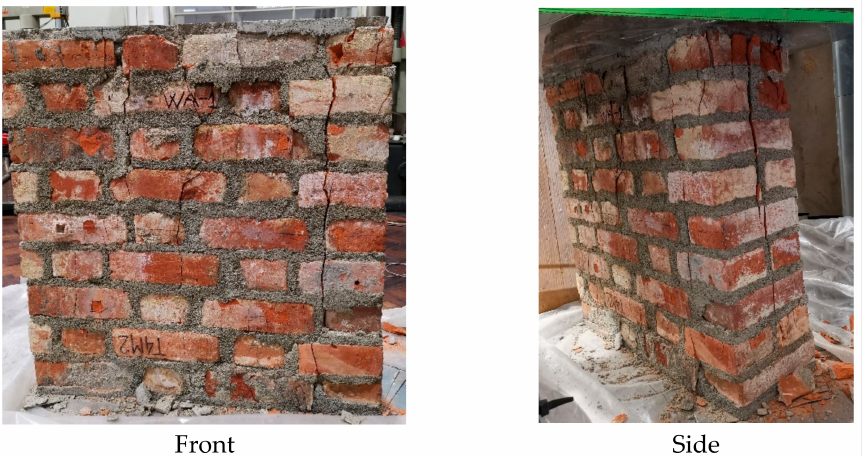
Figure 7. Crack patterns after the axial compression